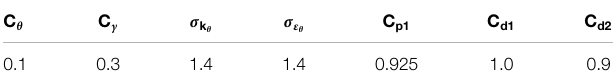
TABLE 4 | The constant empirical coef fi cients of the Manservisi k θ − ε θ turbulent heat transfer